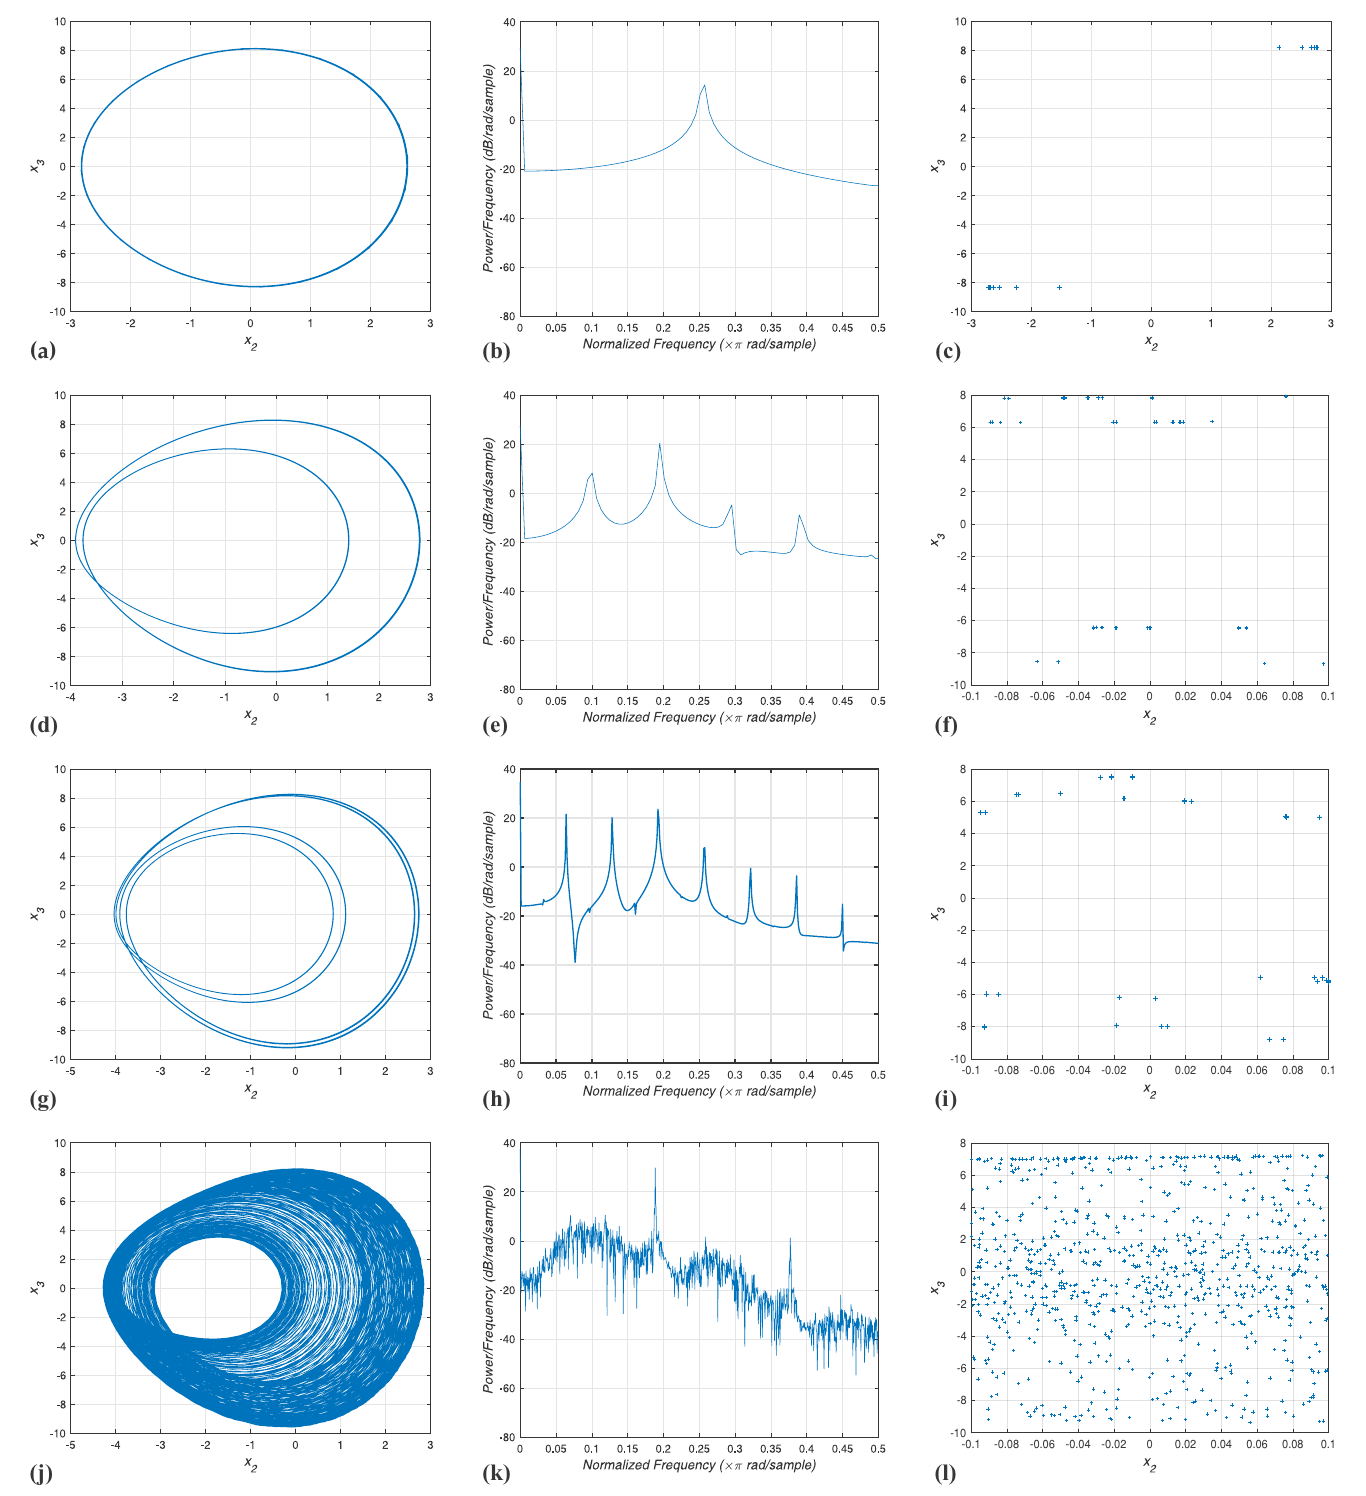
Figure 7. Attractor ( left ), Frequency Spectrum ( center ), & Poincare Section: ( right ) ( a – c ) Period 1 or Limit Cycle Attractor case for β = 9, ( d – f ) Period 2 Attractor case for β = 6, ( g – i ) Period 4 Attractor case for β = 5.84, ( j – l ) Chaotic Attractor case for β =